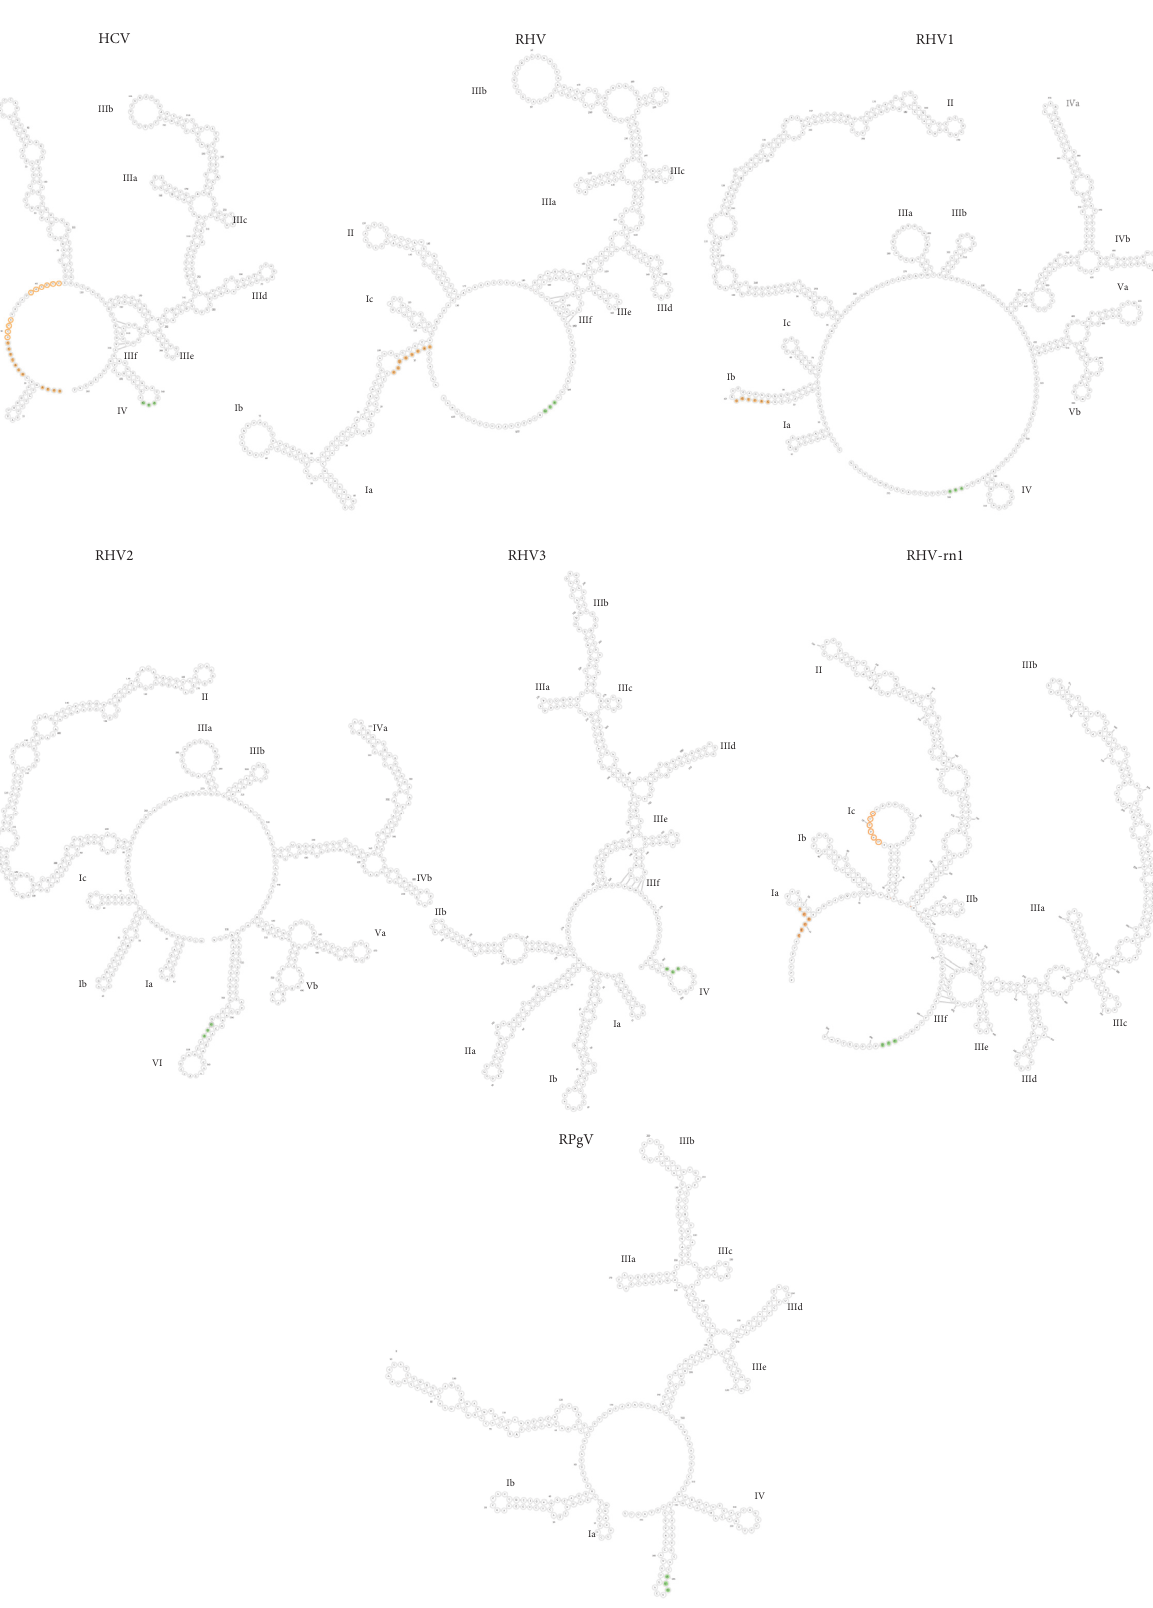
Figure 1: Predicted RNA secondary structures within HCV, RHV, RHV1, RHV2, RHV3, RHV-rn1, and RPgV 5 ′ UTR. The sequence corresponding to the mir-122 binding sites within the 5 ′ UTR is highlighted in orange; the first binding sites are represented by filled circles and the second by the outline. HCV contains two mir-122 binding sites and RHV, RHV1, and RHV-rn1 contain one predicted binding site. RHV2/3 and RPgV do not contain a mir-122 binding site. The nucleotides corresponding to the AUG start codon are highlighted by filled green